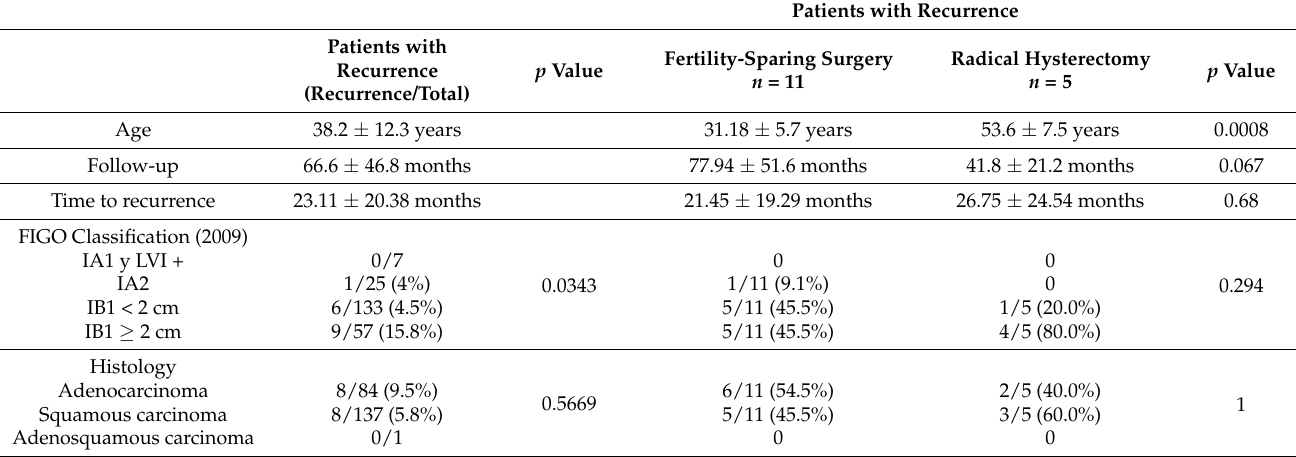
Table 2. Clinicopathological characteristics of the patients with